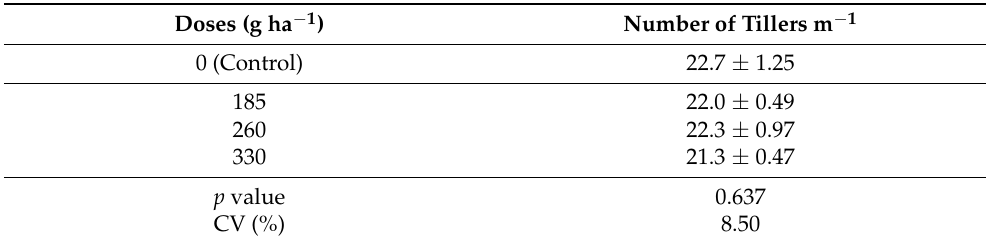
Average ± standard error. Table 4. Number of tillers per meter as a function of Zn dose and application method (df = 24).